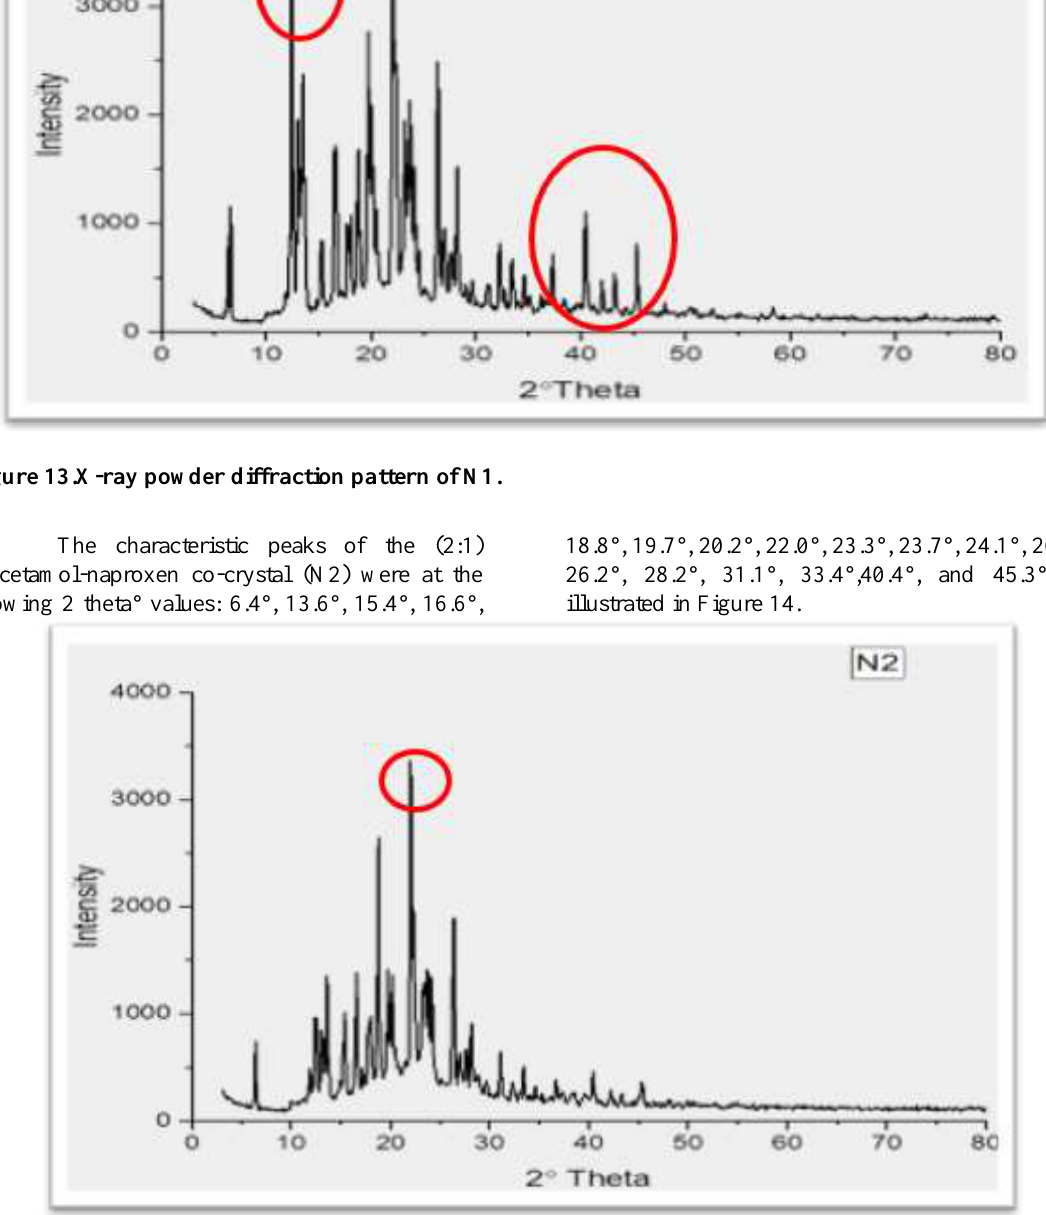
Figure 14. X-ray powder diffraction pattern of N2. The (1:2) paracetamol-naproxen co-crystal (N3) exhibited the following characteristic peaks: 6.6°, 12.5°, 13.6°, 16.7°, 17.9°, 18.8°, 19.7°, 22.3°,